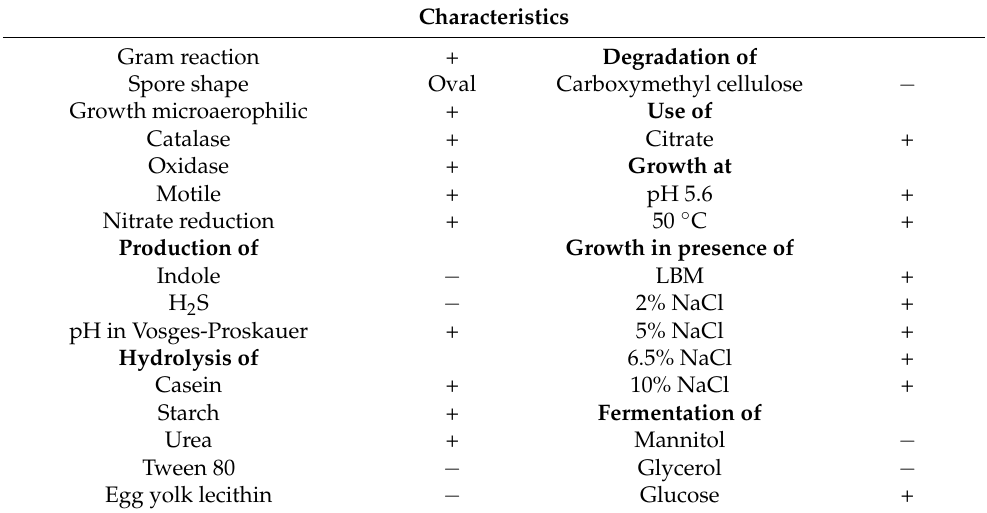
Table 1. Morphological, physiological and biochemical characteristics of B . subtilis subsp. spizizenii